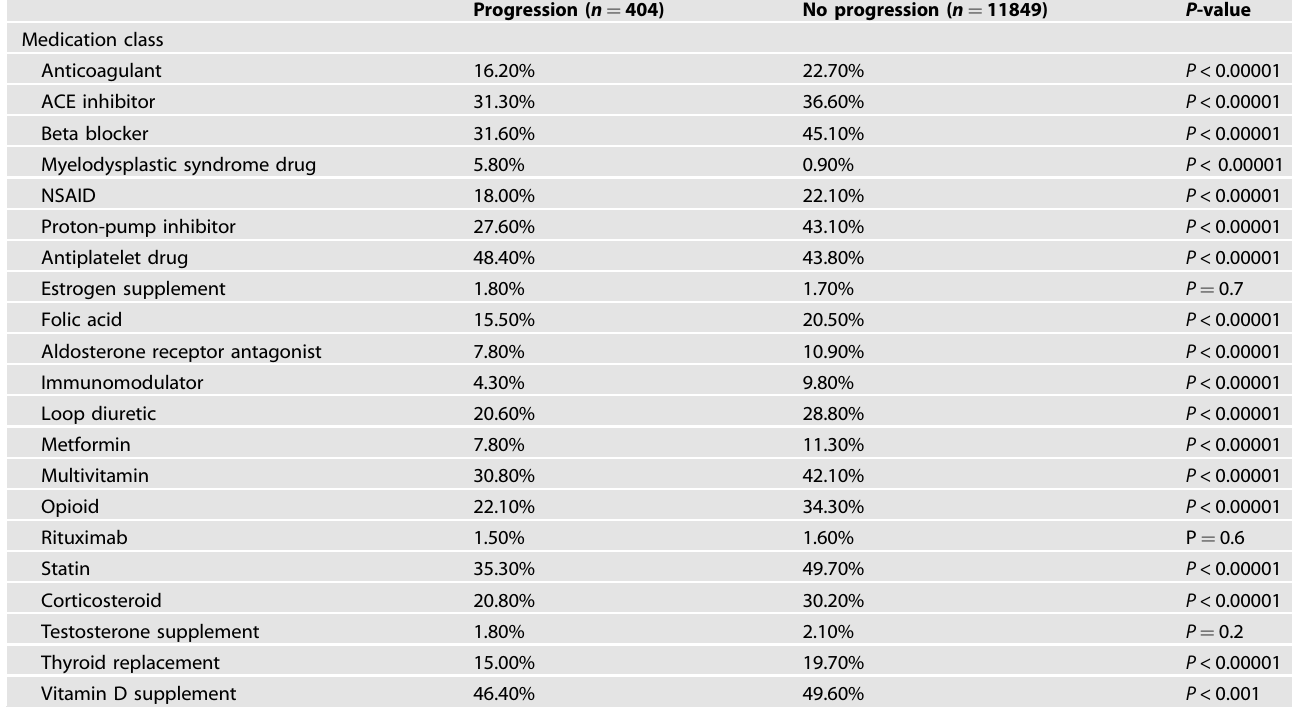
Table 2. Frequency of medication usage by progression